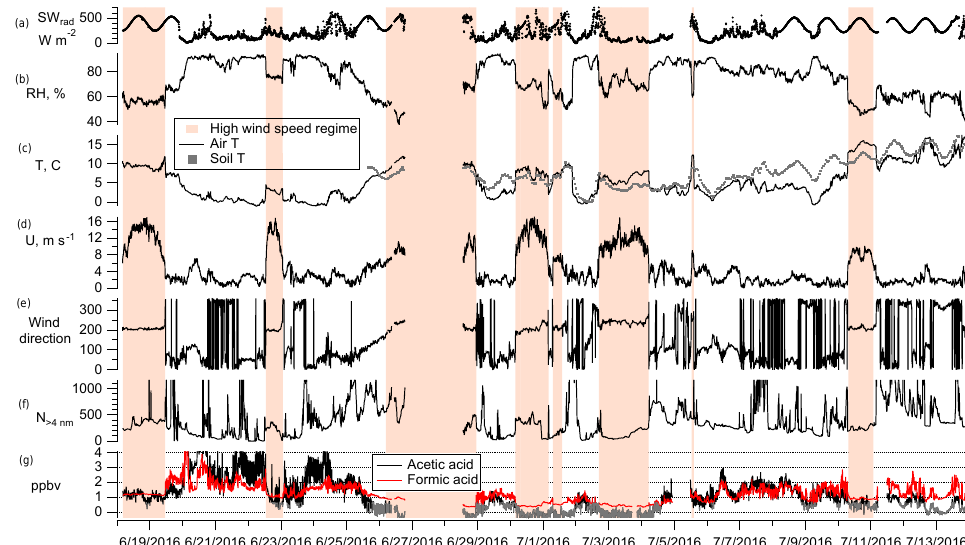
Figure 3. Time series of all data collected for the campaign (5min averages). From top to bottom: total downwelling shortwave radiation, relative humidity, air temperature and soil temperature, wind speed, wind direction, aerosol particles, and FA (red) and AA (black, with values below the detection limit shown in gray.) The vertical axis is truncated at 4ppbv for the organic acids and 1200cm − 3 for the aerosol particles. Orange bars highlight the high wind speed regime.